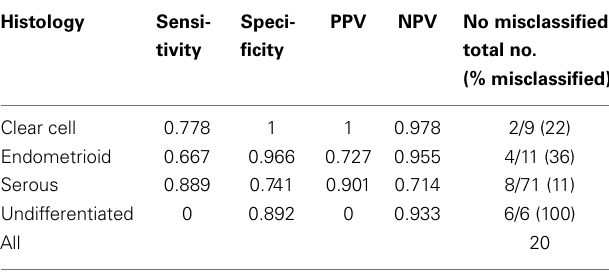
Table 3 | Classification of the tumor samples according to the histological type using linear discriminant analysis.